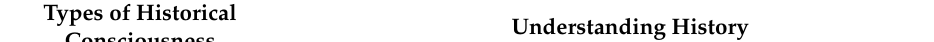
Table 1. Epistemic qualities of historical consciousness (adapted from Seixas 2006, pp.